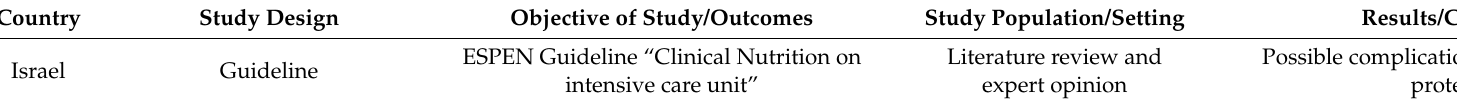
Table 1. Literature, terms, and